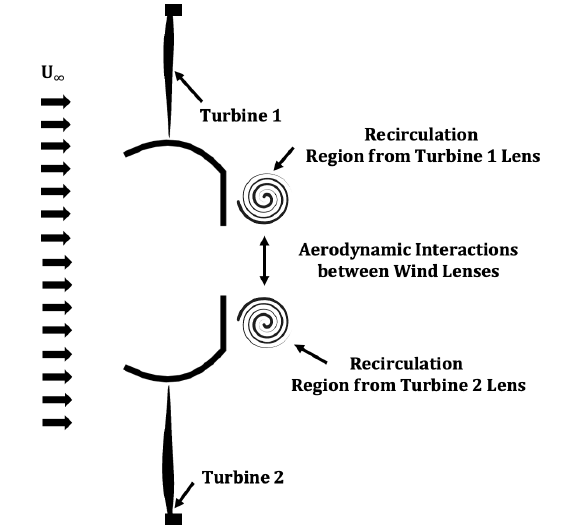
Figure 2. Schematic illustrating the aerodynamic interactions between two lensed turbines in a side- by-side arrangement.